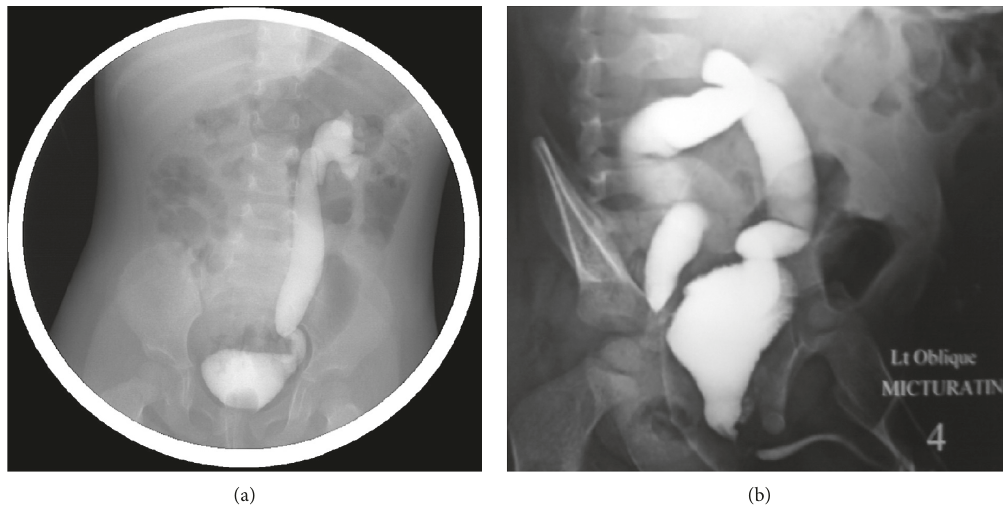
Figure 1: (a) Voiding cystourethrography image shows grade V left vesicoureteral reflux. (b) Voiding cystourethrography image shows bilateral vesicoureteral reflux grade V in a newborn.